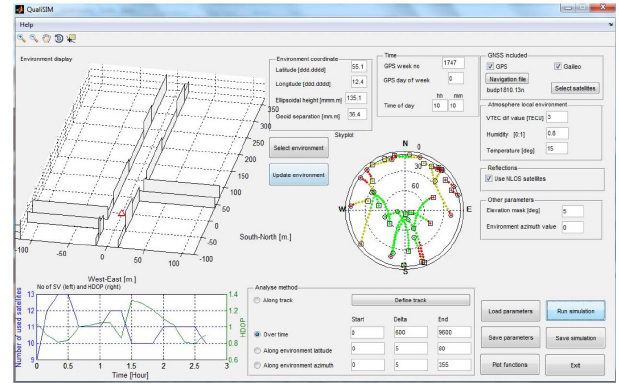
Figure 1: The graphical user interface for QualiSIM